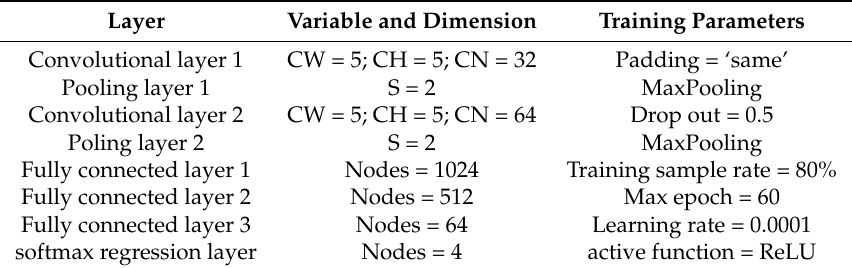
Table 1. Key parameters of selected CNN